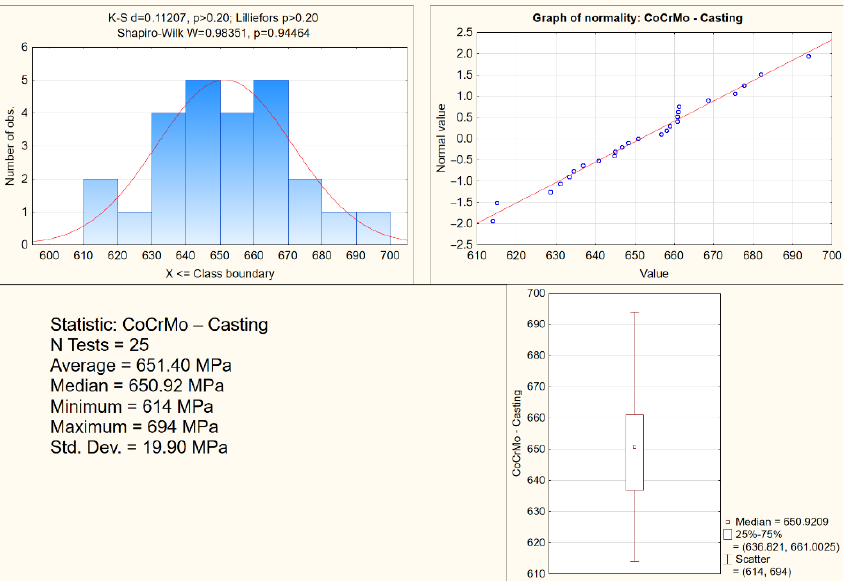
Figure 6. An exemplary analysis of the distribution normality of the offset yield strength in tensile tests for CoCrMo from casting.